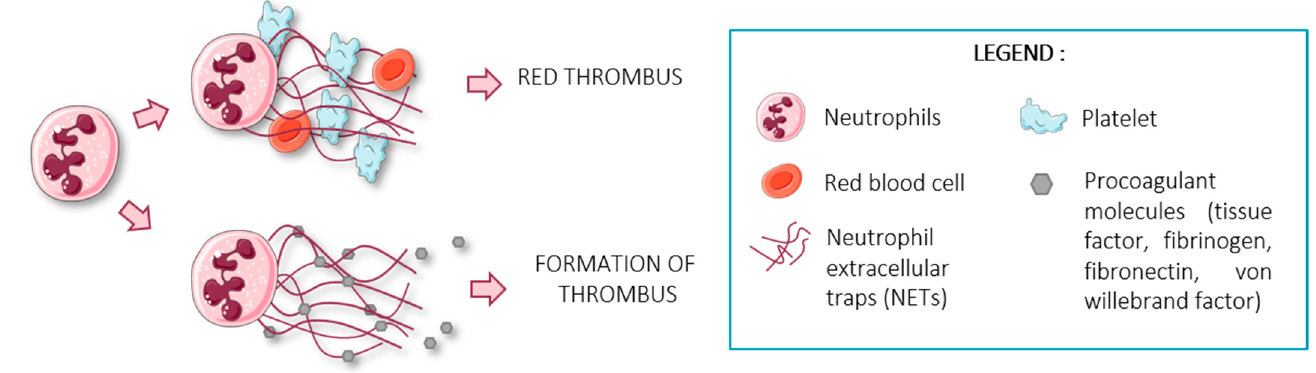
Figure 2. Schematic representation of NET interactions and implications in thrombosis. NETs are capable of trapping platelets and red blood cells, forming a red thrombus. In addition, they express pro-coagulant molecules such as tissue factor, fibrinogen, fibronectin or Von Willebrand factor, which initiate the coagulation cascade and participated to the thrombus formation. Figure created using Servier Medical Art available at http://smart.servier.com/ (accessed on 15 September 2021).